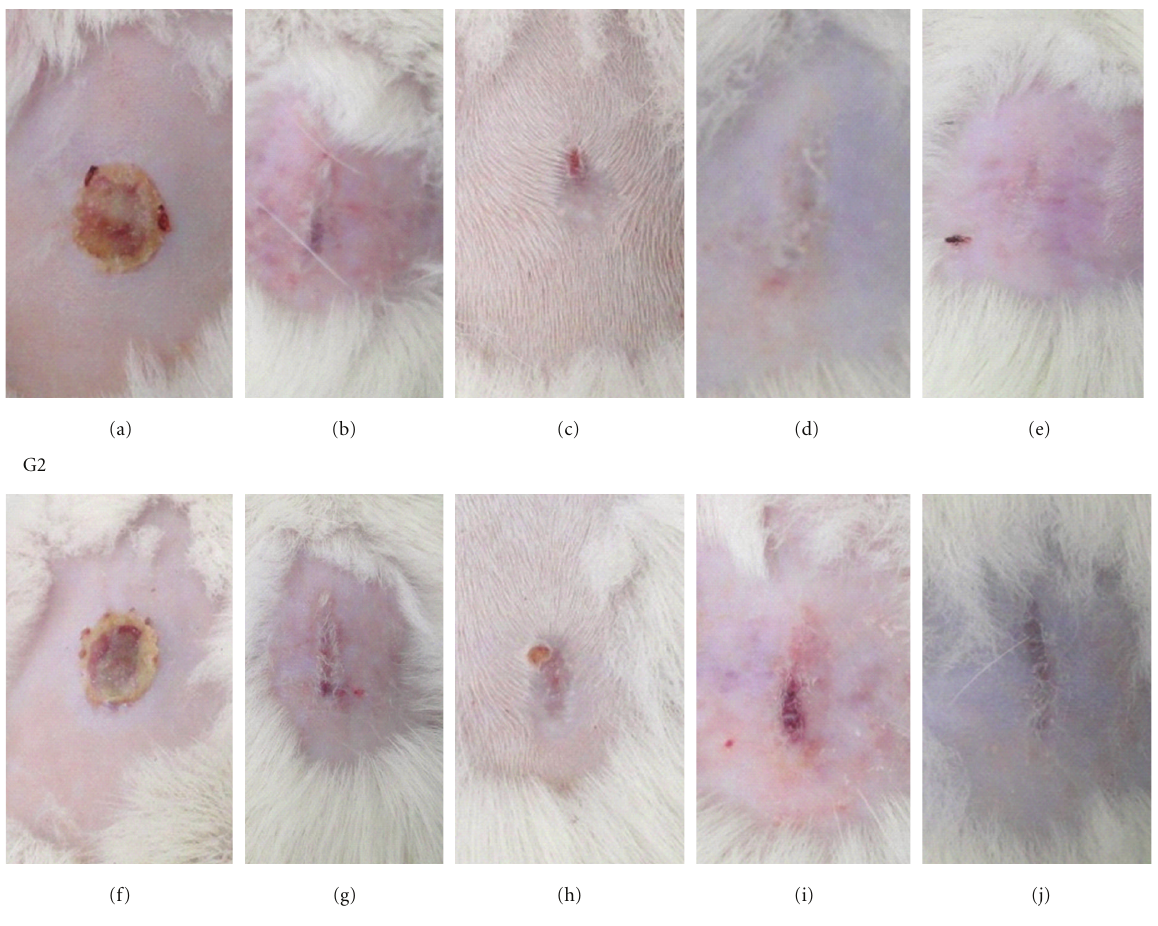
Figure 3: Clinical evaluation of second-degree burn healing in Wistar male rats. G1: experimental group treated with hydrogel containing isolectin Cramoll 1,4 at 100 µ g/mL. (a) Thermal lesion aspect after 7 days: macroscopically shows thin and dry crust with detachment of edges. (b) Thermal lesion aspect after 14 days of treatment: absence of crust and the presence of scar tissue. (c) Thermal lesion aspect after 21 days of treatment: presence of scar tissue and a small detachment point of the crust. (d) Thermal lesion aspect after 28 days of treatment: presence of scar tissue only. (e) Thermal lesion aspect after 35 days of treatment: view of a discrete scar tissue. G2: control group treated by topical application of hydrogel excipient. (f) Thermal lesion aspect in control animals after 7 days: view of thin and dry crust with detachment of edges. (g) Thermal lesion aspect in control animals after 14 days: absence of crust and the presence of scar tissue. (h) Thermal lesion aspect in control animals after 21 days: presence of scar tissue, with the point of detachment of the crust. (i) Thermal lesion aspect in control animals after 28 days: presence of scar tissue and a second crust. (j) Thermal lesion aspect in control animals after 35 days: view of scar